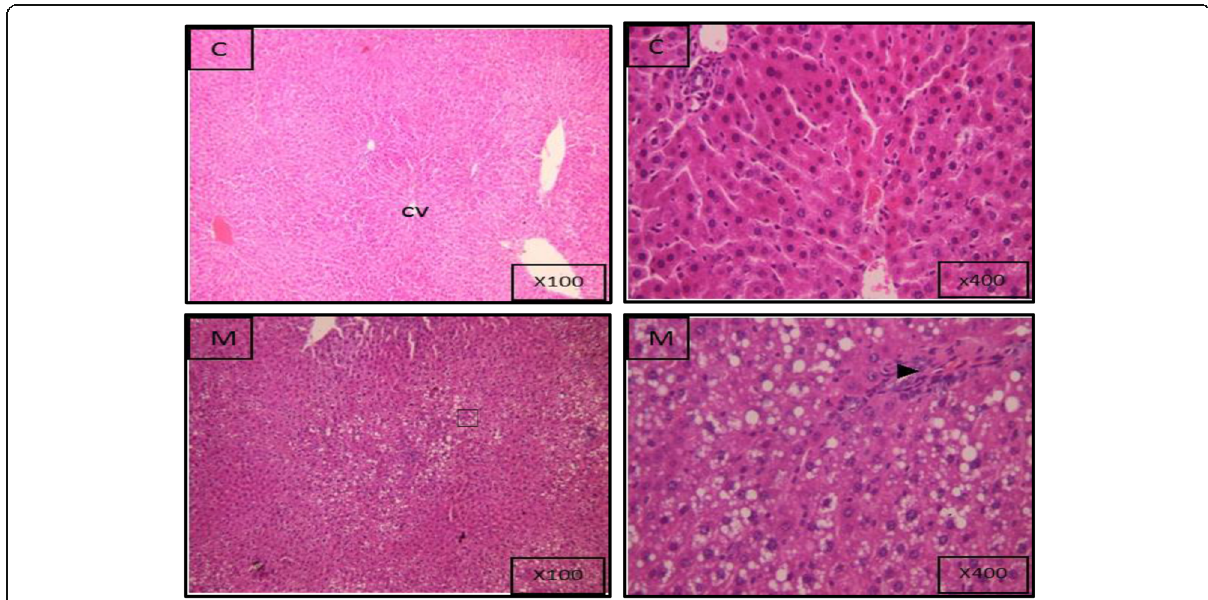
Fig. 6 Liver tissue photomicrograph of control (C) and metabolic syndrome (M) groups after 8 weeks (H&E)